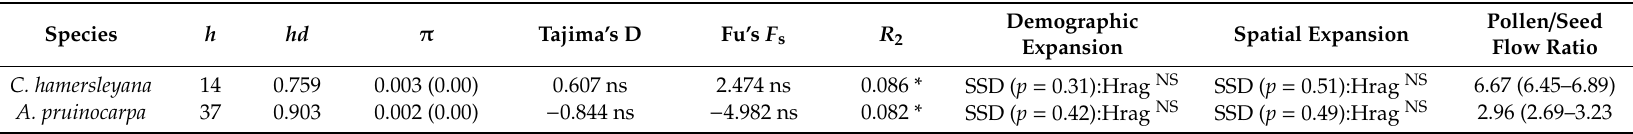
Table 2. Chloroplast DNA diversity statistics, tests for neutrality, and demographic and spatial expansions based on three sequenced regions (rpl16 intron, ndhC-trnV, trnG intron) from 20 populations of C. hamersleyana , and four sequenced regions (ndhF-rpl32, rpl32-trnL, trnS-trnG, psbD-trnT) from 23 populations of A. pruinocarpa